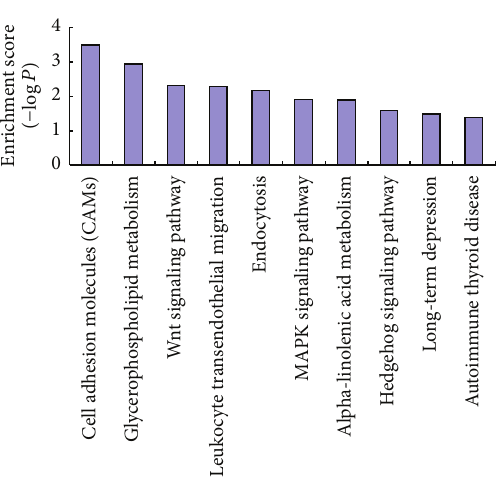
Figure 3: KEGG pathway analysis of genes that were regulated by differentially expressed miRNA. The enrichment score of each pathway was computed (enrichment score = − log 𝑃